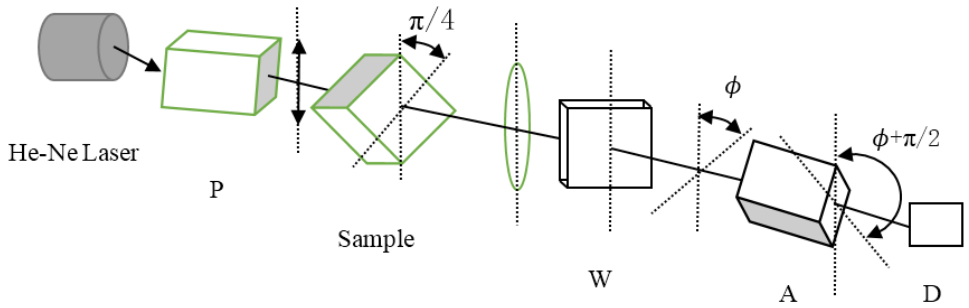
Figure 2. Experimental arrangement for measuring optical homogeneity. P, Polarizer; W, λ /4 wave plate; A, Analyzer; D, Detector.